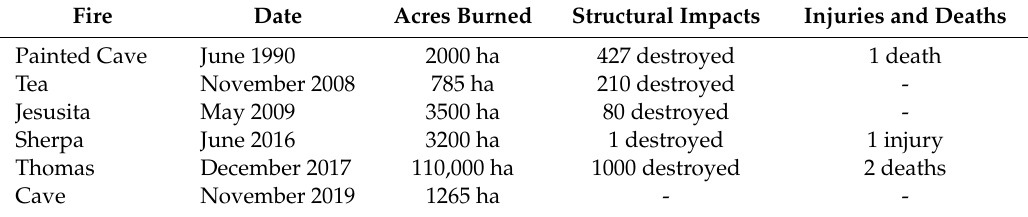
Figure 1. Region of interest (red rectangle; a ) and perimeters of past wildfires in coastal Santa Barbara County between 1970 and 2019 ( b ), colored by the year of occurrence. The “PAINT” Fire is the Painted Cave Fire examined in this study. The thick, black lines indicate major roads and freeways (Highway 101 and Highway 154), and the two blue squares indicate weather stations used in this analysis. Table 1. Information on past wildfires in coastal Santa Barbara County. It should be noted that the Thomas Fire ignited to the east of Santa Barbara in Ventura County and spread west in the first two weeks after ignition. The numbers in the table are from o ffi cial reports that incorporate areas in coastal Santa Barbara. Additionally, the structural impacts, injuries, and deaths associated with the Montecito debris flow caused by the Thomas Fire were not